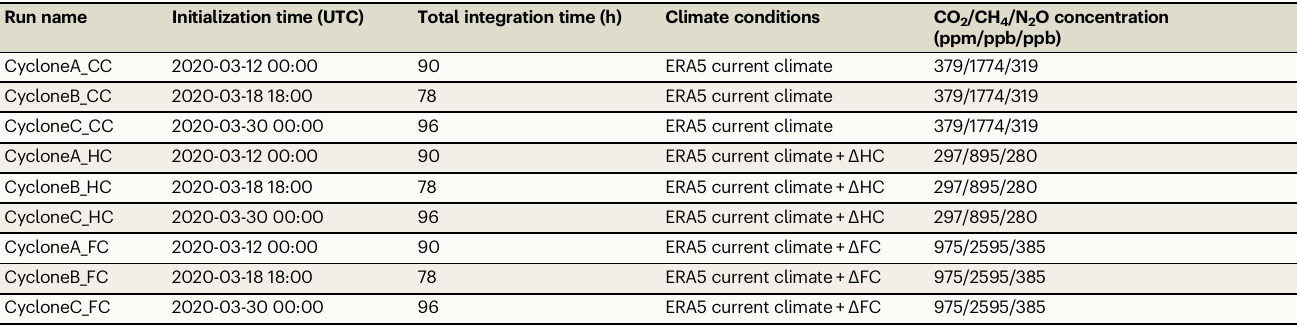
Table 2 | Experimental set-up for the model simulations of cyclone case studies under different climate